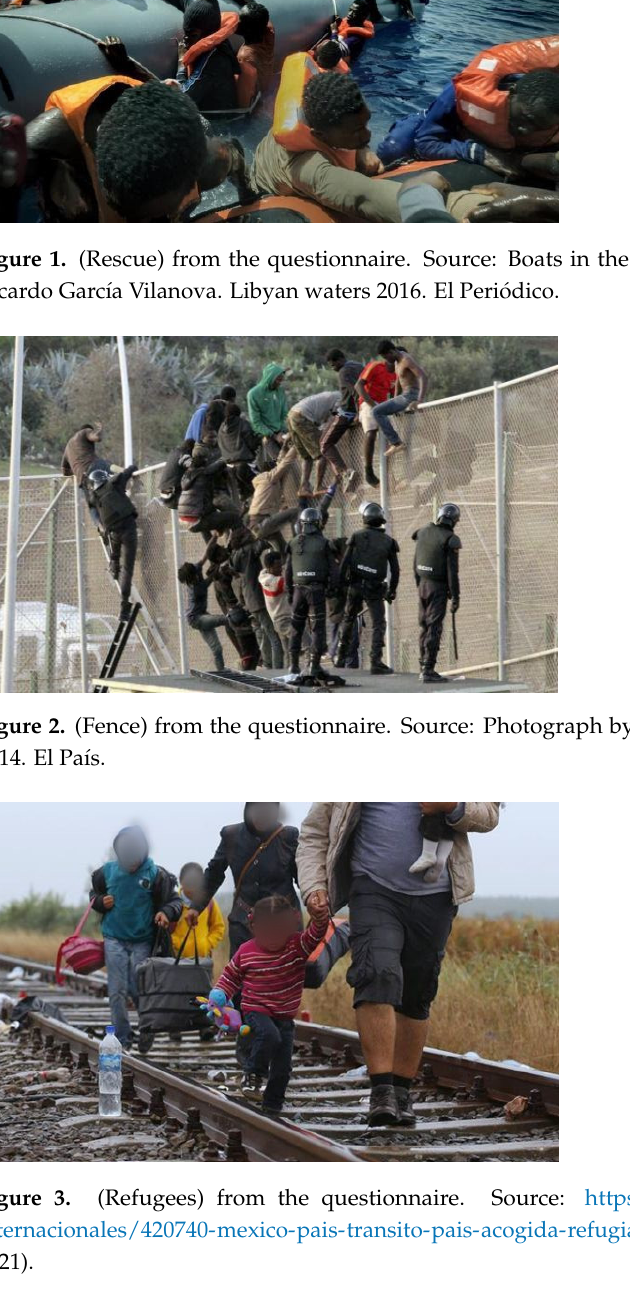
Figure 3. (Fence) from the questionnaire. Source: Photograph by Antonio Ruiz. Melilla, October Figure 2. (Refugees) from the questionnaire. Source: https://www.elnuevodiario.com.ni/internac- Figure 3. (Refugees) from the questionnaire. Source: https://www.elnuevodiario.com.ni/ 2014. El País. ionales/420740-mexico-pais-transito-pais-acogida-refugiados/.